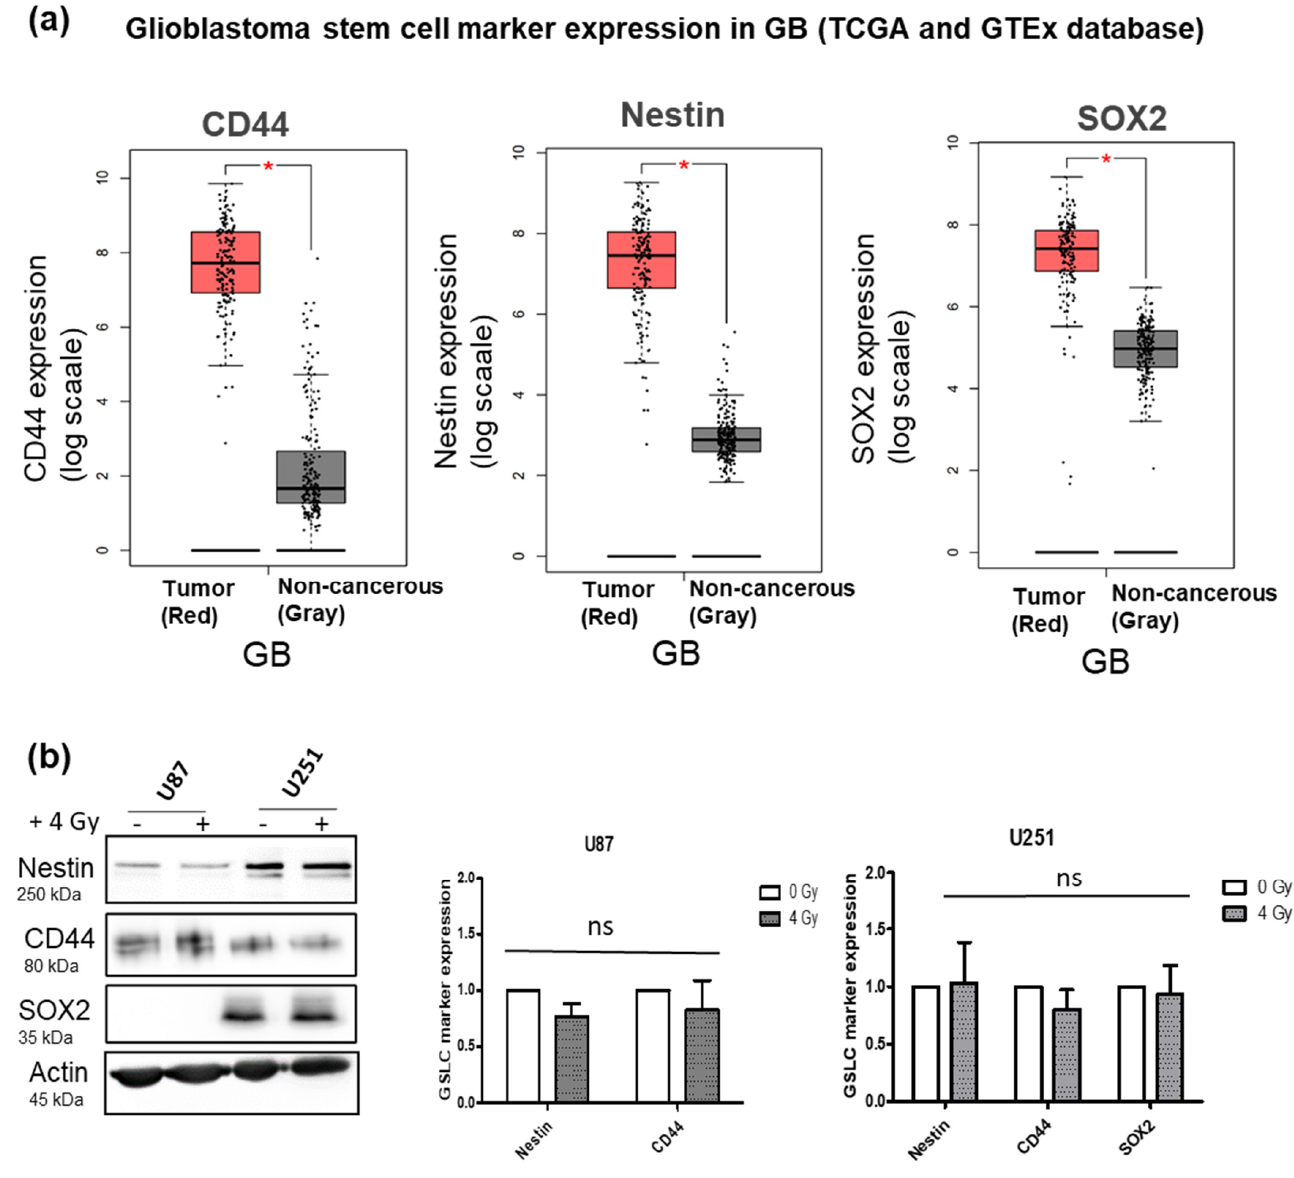
Figure 1. Glioblastoma stem cell marker expression in GB (from TCGA and GTEx database) and GB cell lines: ( a ) TCGA database comparison of GB stem cell marker (CD44, Nestin and SOX2) expression between GB (red; 163 samples) and non-cancerous tissue (gray; 207 samples). Box plots derived from matching TCGA normal and GTEx data downloaded via the GEPIA webserver (* p -value < 0.05). ( b ) Protein expression of CD44, Nestin and SOX2 in U87 and U251 GB cell lines and the effect of 4 Gy irradiation. Data represent mean values of three replicates and the error bars ± SEM ( n = 3; ns—nonsignificant).